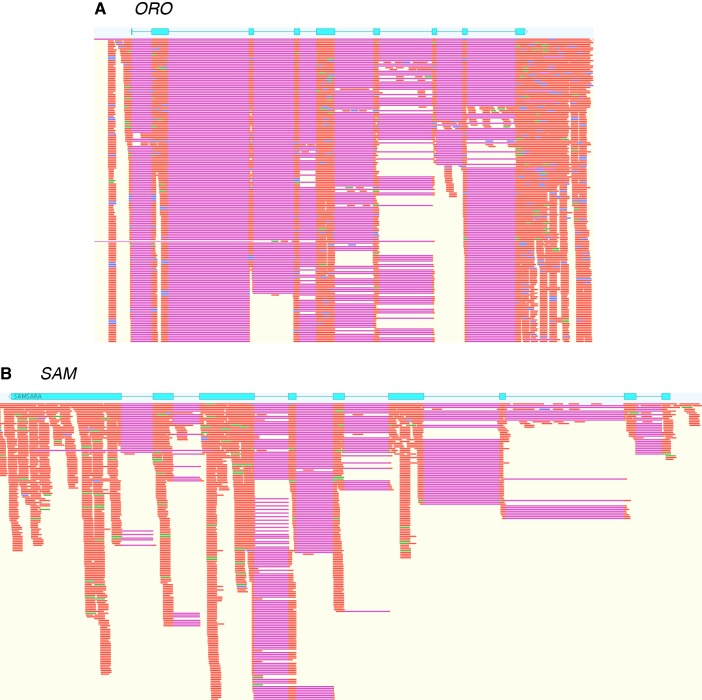
Evidence for the production of full-length ORO and SAM transcripts during the gametophyte generation.Immature and mature male and female gametophyte Illumina RNA-seq data was mapped onto the ORO and SAM gene sequences using Tophat2. Blue boxes, ORO and SAM coding exons; orange, RNA-seq reads; purple, gaps introduce during mapping corresponding to introns.